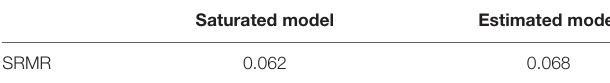
TABLE 5 | Model fit (standardized root means square residual).